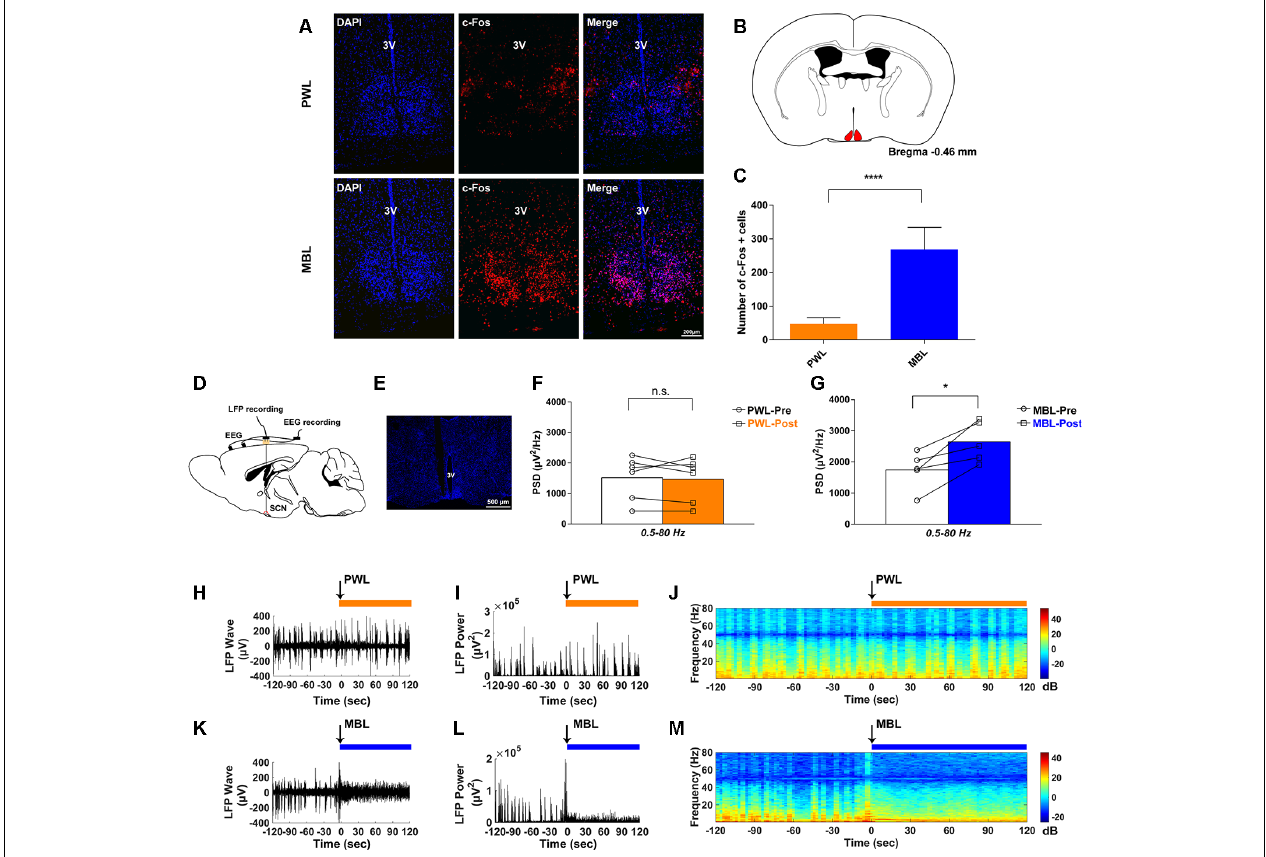
FIGURE 3 | MBL drove suprachiasmatic nucleus (SCN) activation during sevoflurane anesthesia. (A) Effect of PWL (upper) and MBL (lower) on c-Fos immunostaining and DAPI nuclear staining in the SCN during sevoflurane anesthesia. 3V, third ventricle. Scale bar = 200 µ m. (B) Position of the SCN in the mouse brain atlas. The red indicates the SCN. (C) Quantitative analysis of the number of c-Fos-positive cells in the PWL and MBL groups. c-Fos expression in the SCN region with MBL treatment was significantly higher than in the PWL treatment group (**** p < 0.0001 compared with PWL, n = 8 in each group, and unpaired Student’s t -tests with Welch’s correction). Data are expressed as mean ± SD. (D) Schematic of the experiment. EEG and local field potential (LFP) in the SCN were simultaneously recorded. (E) The coronal section containing the track of an electrode localized to the SCN. 3V, third ventricle. Scale bar = 500 µ m. (F) Quantitative spectral analysis computed from 2 min before PWL (white) and 2 min after PWL (orange) on the entire frequency band (1–80 Hz). The PWL-treated animals showed no statistically significant difference in the SCN LFP power compared to pre-PWL (n.s. = not significant compared with pre-PWL, n = 6, and paired Student’s t -tests). (G) Quantitative spectral analysis computed from 2 min before MBL (white) and 2 min after MBL (blue) on the entire frequency band (1–80 Hz). The MBL-treated animals increased the SCN LFP power compared to pre-MBL (* p < 0.05 compared with pre-MBL, n = 5, and paired Student’s t -tests). (H–J) Representative SCN LFP traces (H) , LFP power (I) , and LFP power spectrogram (J) in a mouse administered PWL. Time 0 indicates the beginning of light stimulation during continuous sevoflurane anesthesia. The orange lines indicate the 120 s intervals used for power spectral density comparisons. (K–M) Representative SCN LFP traces (K) , LFP power (L) , and LFP power spectrogram (M) in a mouse administered MBL. Time 0 indicates the beginning of light stimulation during continuous sevoflurane anesthesia. The blue lines indicate the 120 s intervals used for power spectral density comparisons. PWL, polychromatic white light; MBL, monochromatic blue